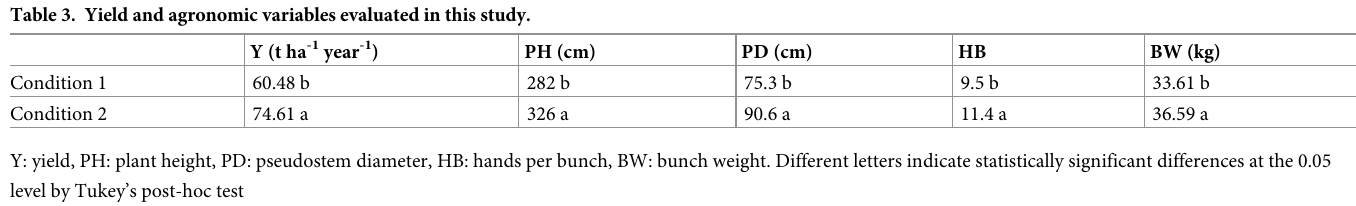
agent in the WSA and SOC. This matches the observations made by Tisdall and Oades [18] and Cabria et al . [49]. The soil aggregate stability may be under the influence of cementing or binding agents, which may be inorganic, organo-mineral association or organic, as is sug- gested by Tisdall and Oades [18]. High contents of SOC were found associated with recalci- trant or stable forms such as soil aggregates size lower than 250 μ m, indicating a high activity of soil microorganisms, which are highly efficient in the decomposition of SOM. Our results further signify a high relation between SOC in aggregates with yield and vigor traits such as plant height and pseudostem diameter (Fig 5). In contrast, condition 1 shows lower SOC con- tent, which may be a reason for lower structural stability. Also, this condition presents low val- ues of OC associated with less recalcitrant form such as aggregate size greater than 250 μ m, as a consequence of the deficient activity of soil microorganisms. Jastrow and Miller [50] suggest that the stability of microaggregates is influenced by the forces with which the particulate frac- tion of OM is able to suck clays, and inorganic and organic compounds, microbial residues, and organic colloids.